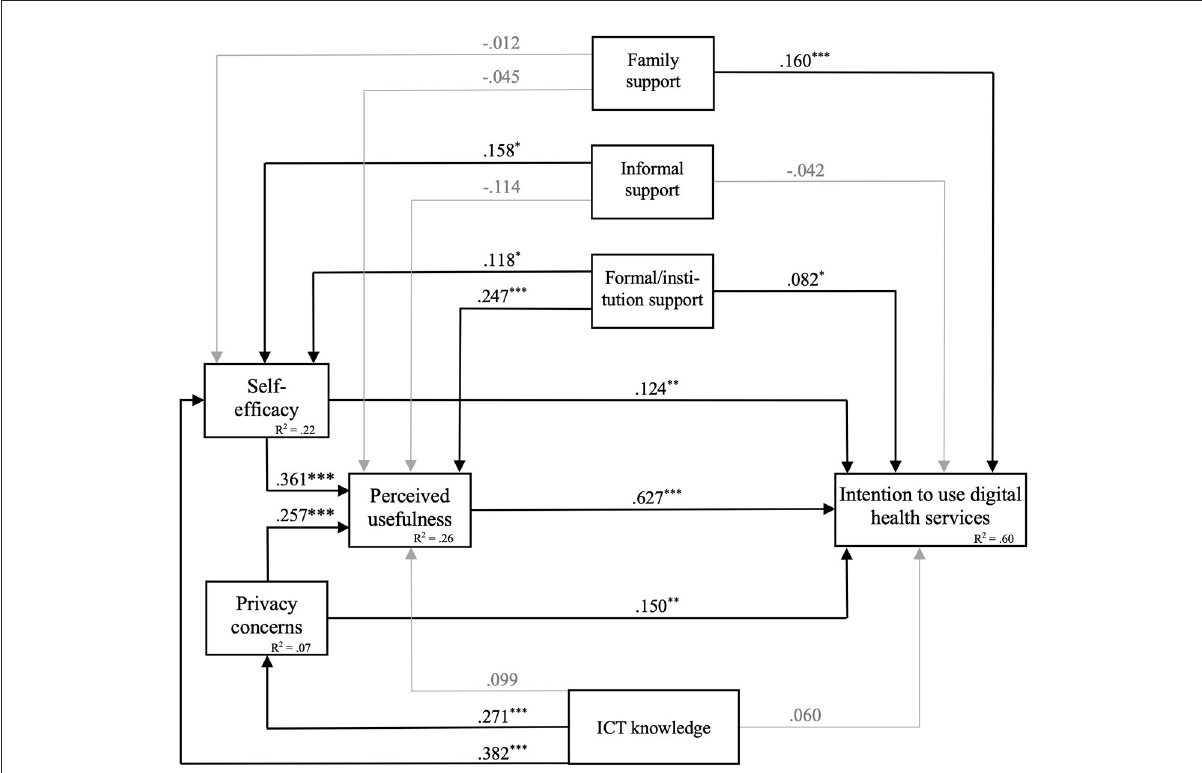
FIGURE1 Path model predicting the intention to use digital health services. Significant β coefficients are depicted black. R 2 = total variance explanation. * p < 0.05; ** p < 0.01; *** p <